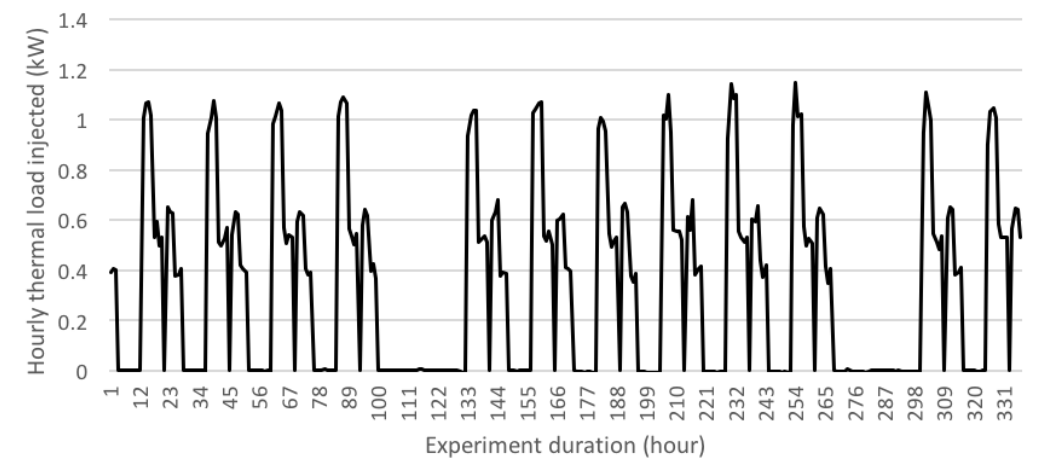
Figure 13. Hourly thermal loads calculated from the experimental data (injected heat rate to the pile during the